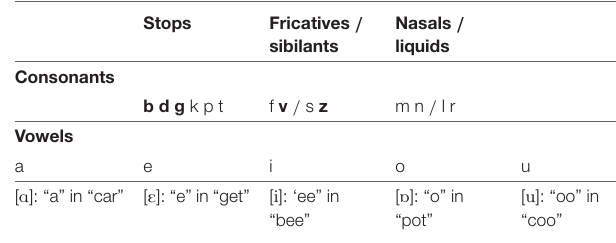
TABLE 1 | Phonemes and phoneme types used in building the